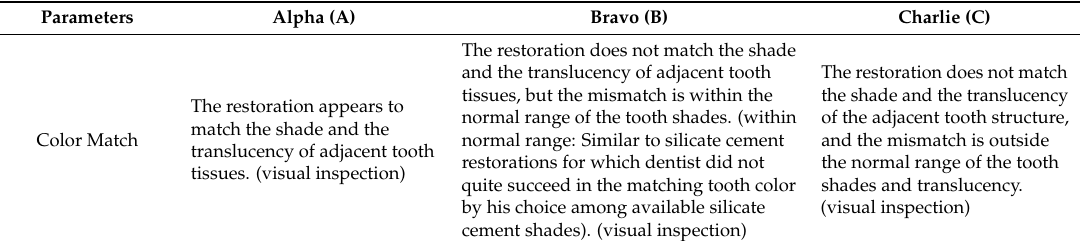
Table 1. U.S. Public Health Service